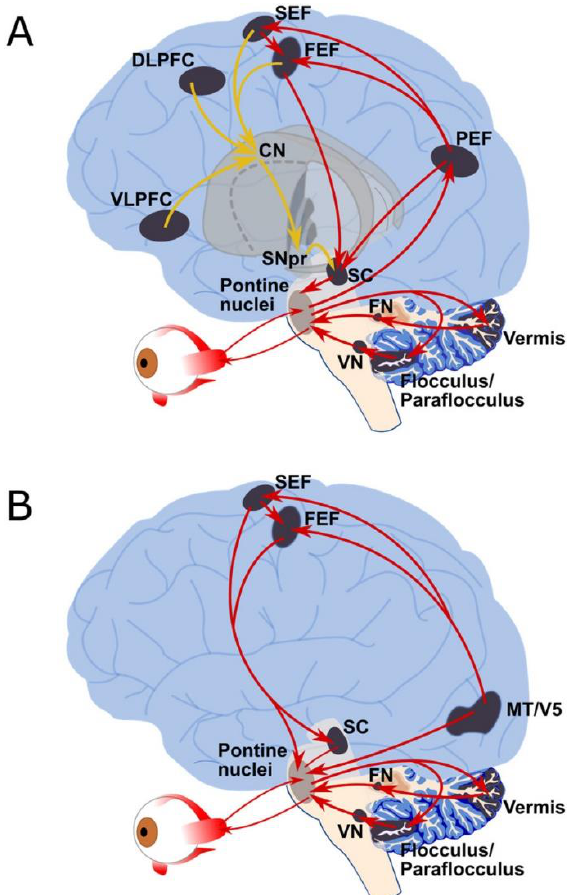
Figure 1. Neuroanatomy of saccadic and pursuit eye movements. Overview of the human ocular motor networks, detailing the descending pathways that control ( A ) saccadic, and ( B ) pursuit eye movements. Grey shaded regions indicate key ocular motor areas, while arrows indicate anatomical connections (may not be direct connections in all cases). ( A ) Saccade pathways: red arrows indicate the direct pathway (PEF, FEF, SEF) to SC and brainstem premotor regions, while yellow lines indicate the indirect pathway to the SC and brainstem premotor regions via the basal ganglia (striatum, subthalamic nucleus, globus pallidus and substantia nigra pars reticula. ( B ) Pursuit pathways: red arrows indicate the main pathways that control pursuit eye movements. CN = caudate nucleus (basal ganglia); DLPFC: dorsolateral prefrontal cortex; FEF = frontal eye fields; FN = fastigial nucleus, MT / V5 = middle temporal area; PEF = parietal eye fields; pontine nuclei = premotor nuclei (paramedian pontine reticular formation (PPRF) and rostral and caudal interstitial fasciculus nucleus of the medial longitudinal fasciculus (riMLF, cMRF); SC = superior colliculus; SEF = supplementary eye field; SNpr = substantia nigra pars reticulate; Vermis = cerebellar vermis lobules VI and VII; VLPFC = ventrolateral prefrontal cortex; VN = vestibular nuclei. (For interpretation of the references to colour in this figure legend, the reader is referred to the web version of this article.) Figure and text with permission from: